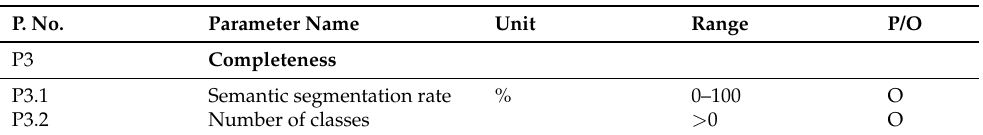
Table 7. Parameters for